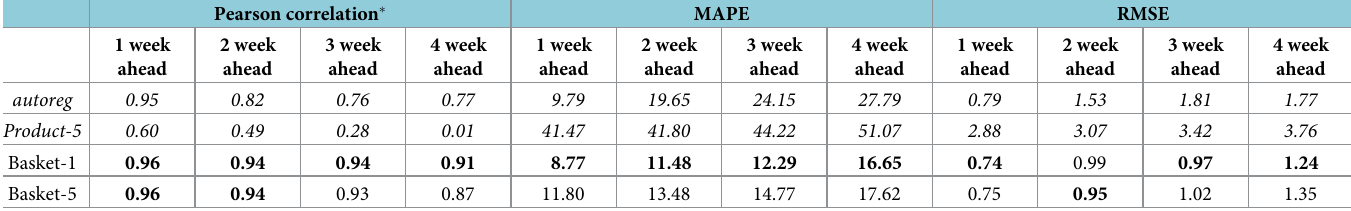
Table 1. Performance indicators. Performance indicators with respect to the Influnet ground truth for the sentinel basket forecast approach and the baselines ( autoreg , Product-5 ) for the whole period